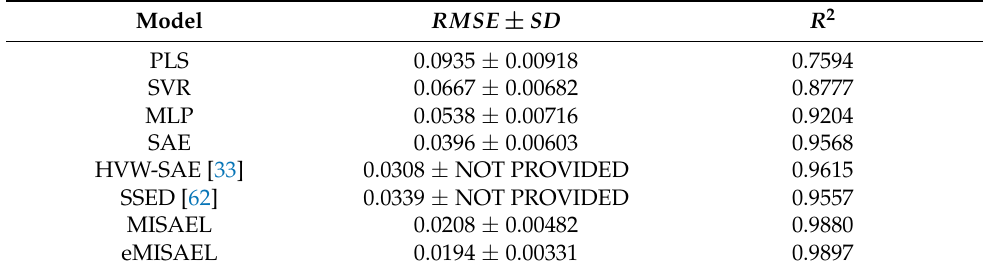
Figure 7. MI between input representations and the output variables for the debutanizer column. Subfigure ( a ) illustrates MI values of the input features. In addition, subfigures ( b – d ) indicate MI values hidden units present in AE-1, AE-2, AE-3, respectively. Table 2. Prediction performance of debutanizer column soft-sensor